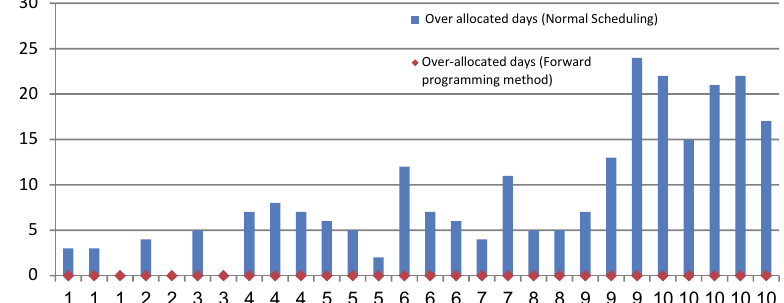
Fig. 11. Comparing number of over allocated days for the solved experiments Validating the proposed